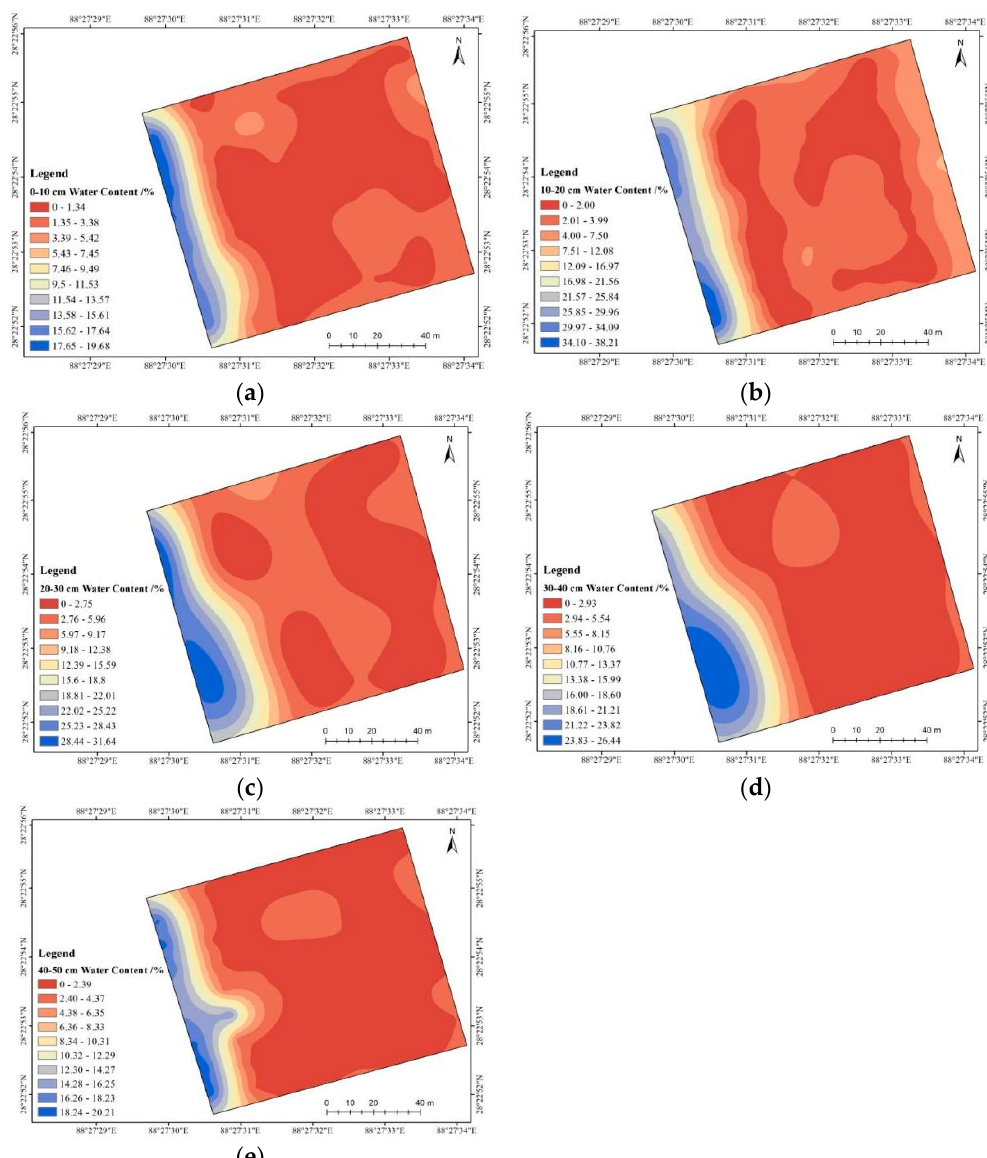
Figure 3. Spatial distribution of soil moisture in different soil layers. ( a ) soil gravimetric water content at 0–10 cm layer, ( b ) soil gravimetric water content at 10–20 cm layer, ( c ) soil gravimetric water content at 20–30 cm layer, ( d ) soil gravimetric water content at 30–40 cm layer, ( e ) soil gravimetric water content at 40–50 cm layer. Table 4. Correlation matrix of soil moisture at different